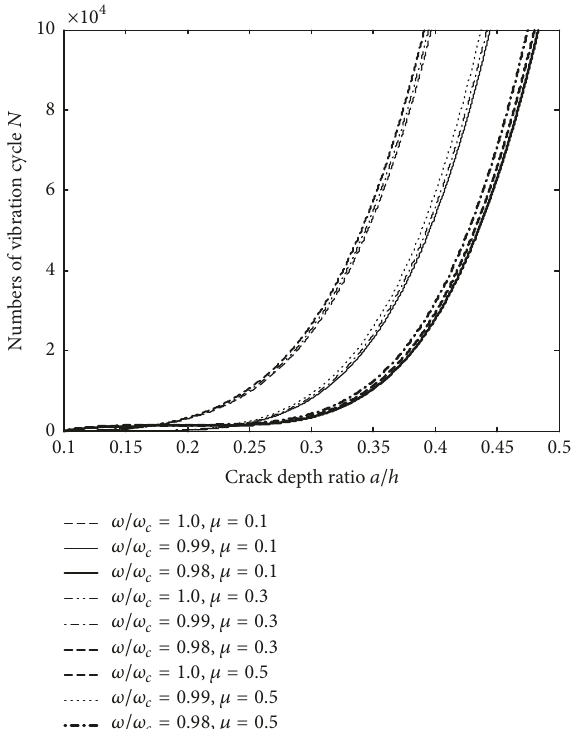
Figure 14: Breathing crack depth with vibration cycles for different friction coefficient and frequency.